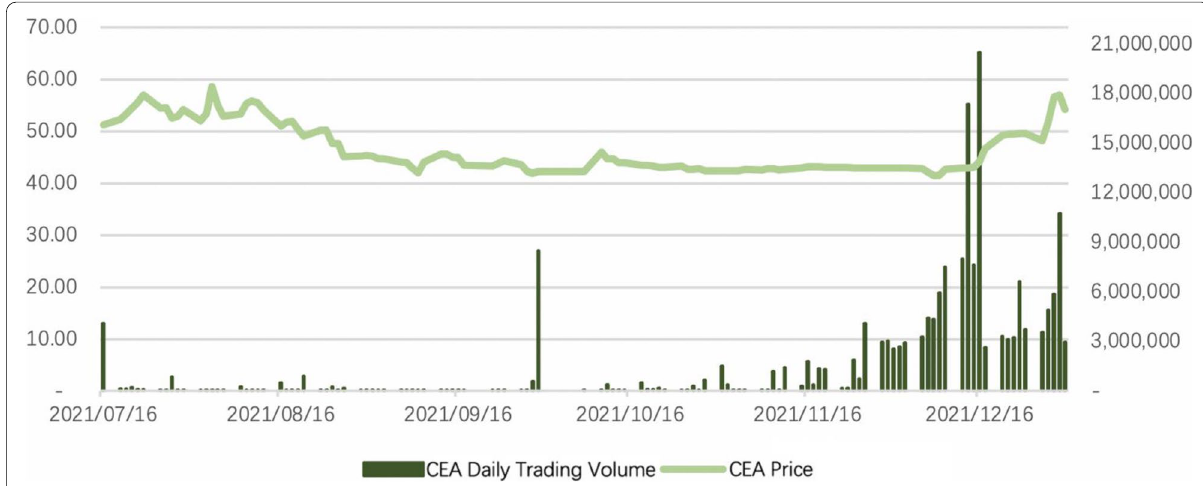
Fig. 3 CEA’s transaction price and volume (Shanghai Environment and Energy Exchange https:// www. cneeex. com/